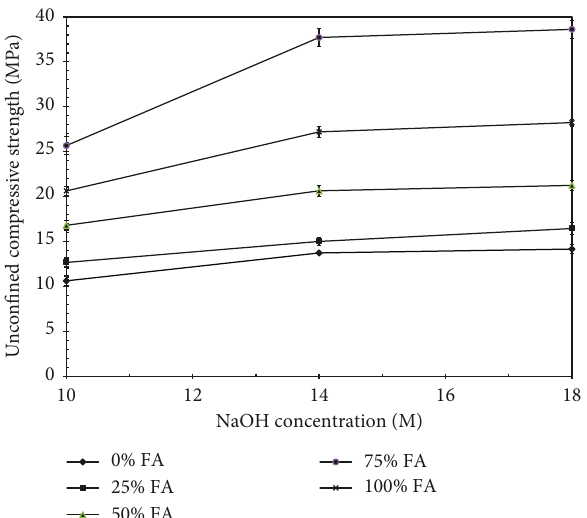
Figure 3: 7 days UCS versus NaOH concentration with different FA contents.